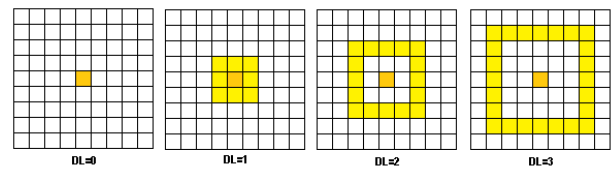
Figure 3. Interconnections existing between Dlayer and Alayer according to the DL parameter